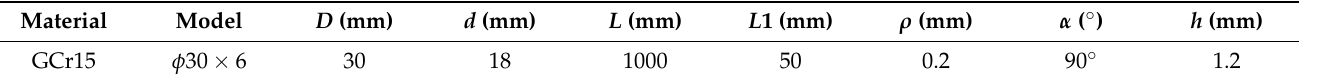
Table 1. Test tube materials and parameters.